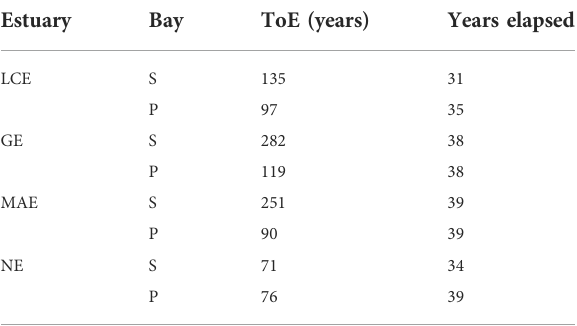
TABLE3Timeofemergencefor Ω arag forprimary(P)andsecondary(S) bays of the four studied nwGOM estuaries.